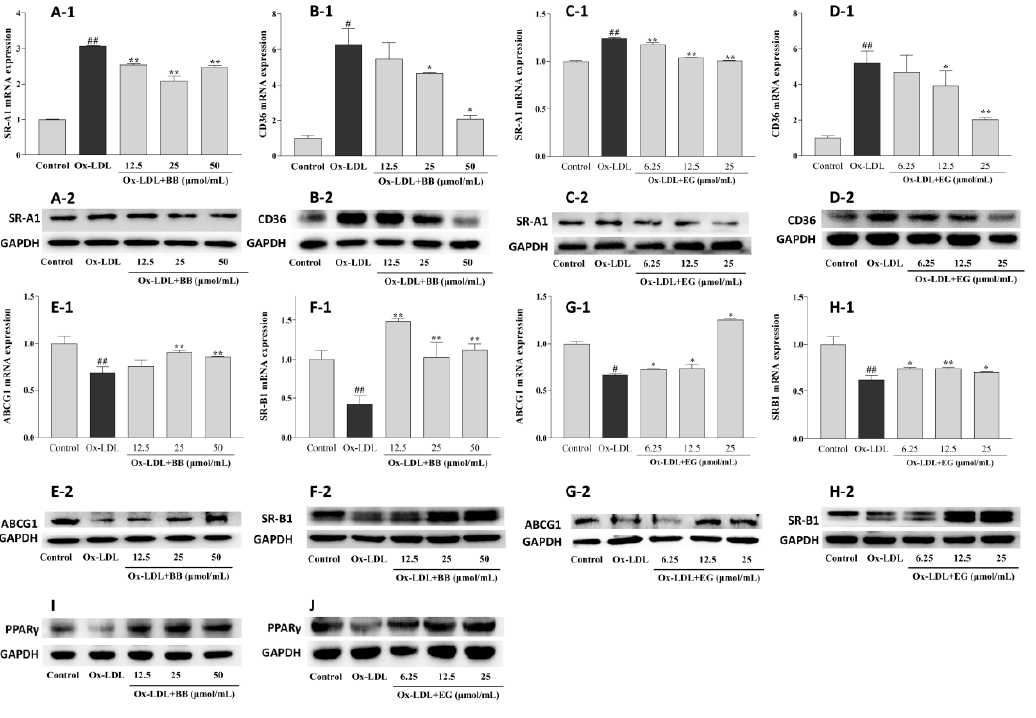
Figure 5. Effects of BB (12.5, 25, 50 µ mol/mL) and EG (6.25, 12.5, 25, 50 µ mol/mL) on SR-A1 and CD36 gene ( A-1 , B-1 , C-1 , D-1 ) and protein ( A-2 , B-2 , C-2 , D-2 ) expressions in the ox-LDL-induced RAW264.7 cells; effects of BB (12.5, 25, 50 µ mol/mL) and EG (6.25, 12.5, 25, 50 µ mol/mL) on ABCG1 and SR-B1 gene ( E-1 , F-1 , G-1 , H-1 ) and protein ( E-2 , F-2 , G-2 , H-2 ) expressions in ox-LDL-mediated RAW264.7 cells; effects of BB (12.5, 25, 50 µ mol/mL) and EG (6.25, 12.5, 25, 50 µ mol/mL) on PPAR γ ( I , J ) protein expression in RAW264.7 cells under ox-LDL (80 µ g/mL) condition. # p < 0.05, ## p < 0.01 vs. the control group, and * p < 0.05, ** p < 0.01 vs. ox-LDL-induced